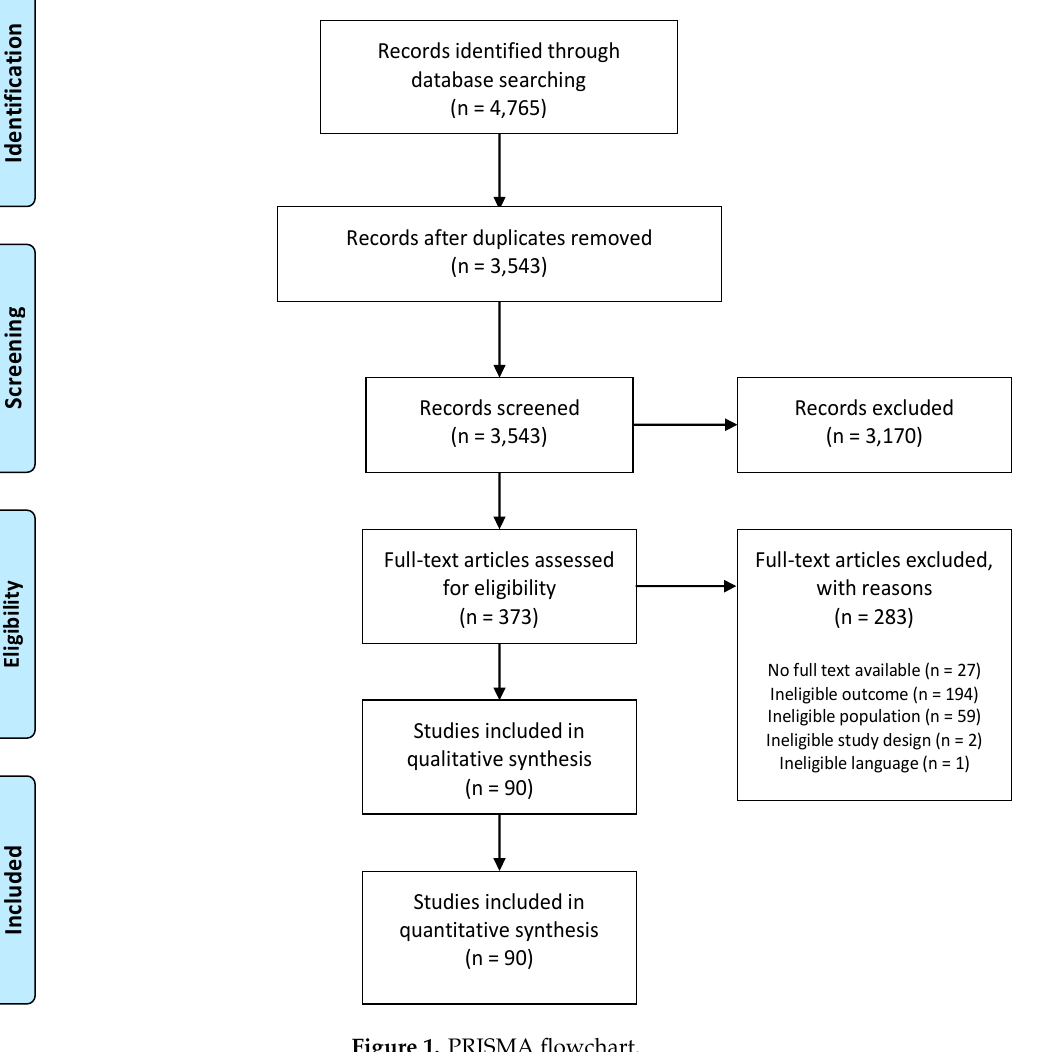
Figure 1. PRISMA flowchart.